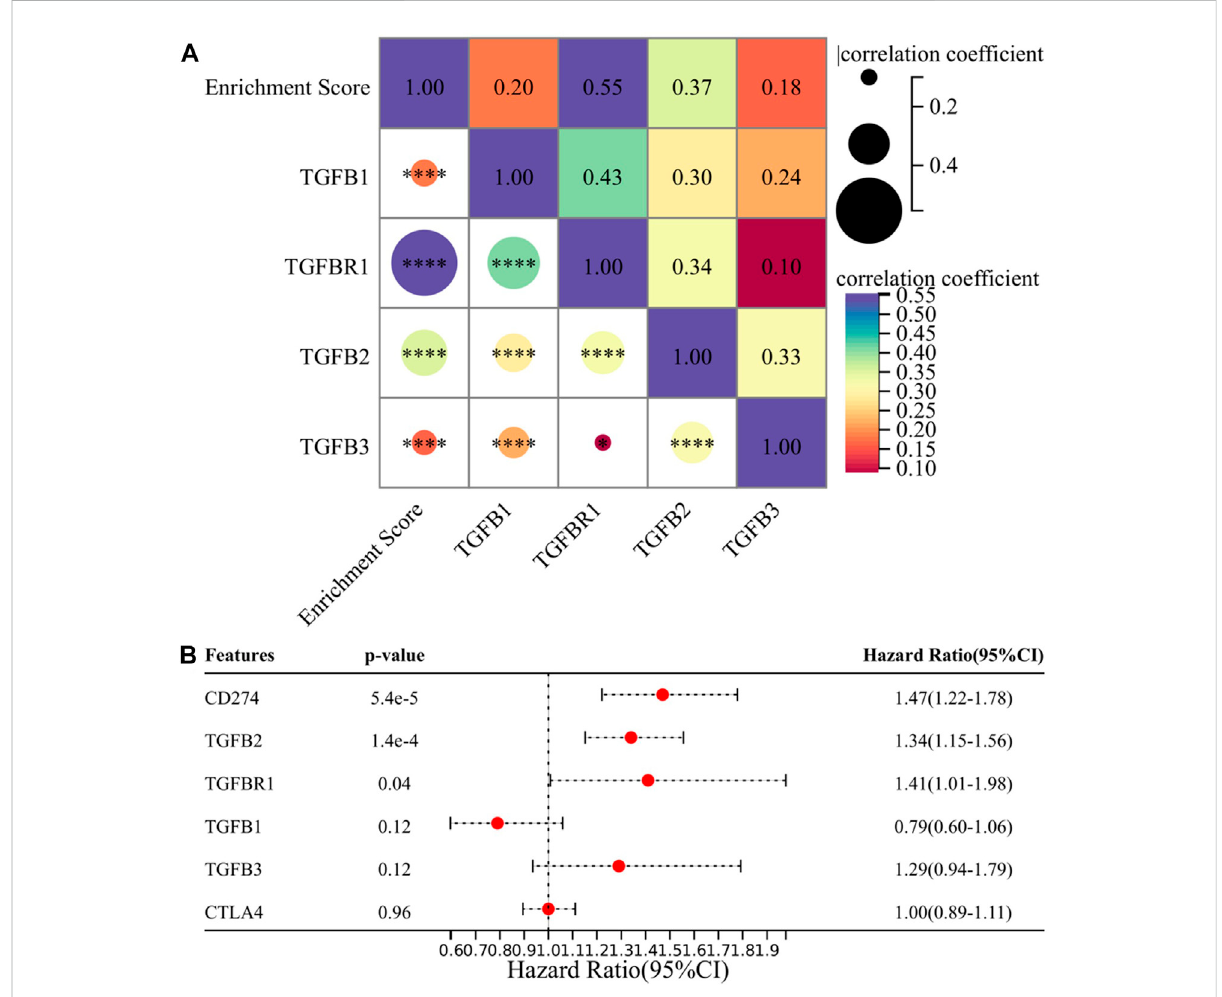
FIGURE 6 TGFB1/TGFBR1 may be a suitable target in the treatment of gliomas. (A) Correlation between TGFB1/TGFBR1, TGFB2, TGFB3, and enrichment score and (B) multivariate survival analysis of TGFB1/TGFBR1, TGFB2, TGFB3, PD-L1, and